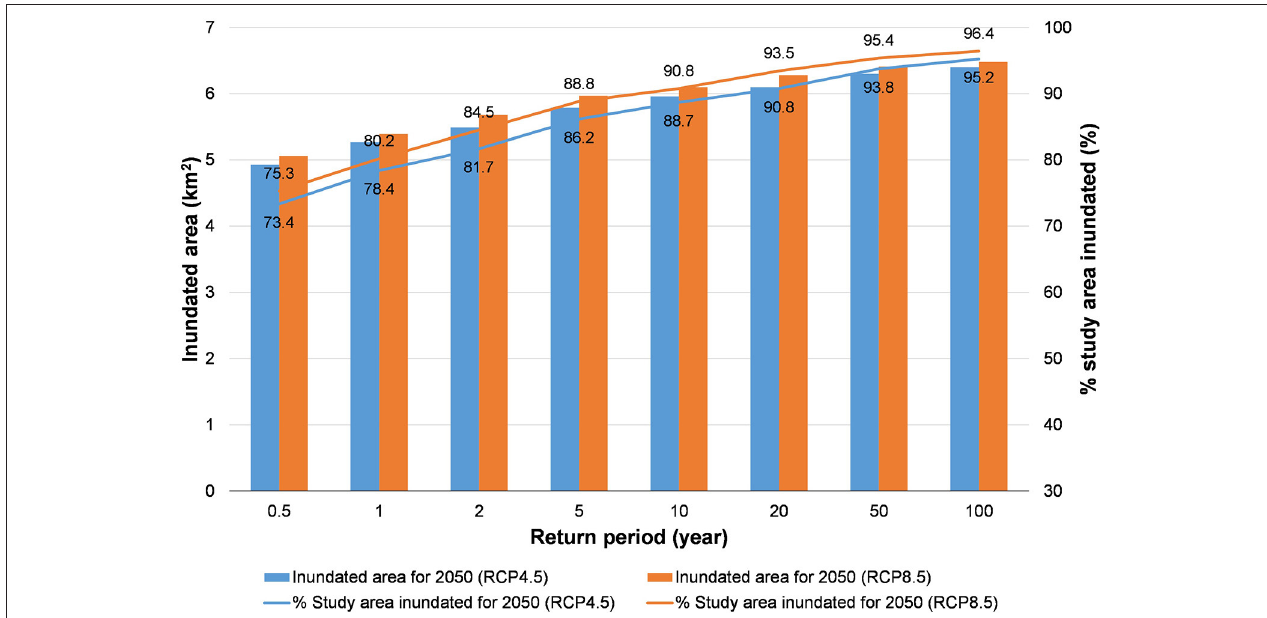
FIGURE 14 | The inundated area and percentage of the flooded area relative to total study area (also indicated by numerics along the solid lines in this figure) corresponding to each return period of water level for model scenarios (including land subsidence).